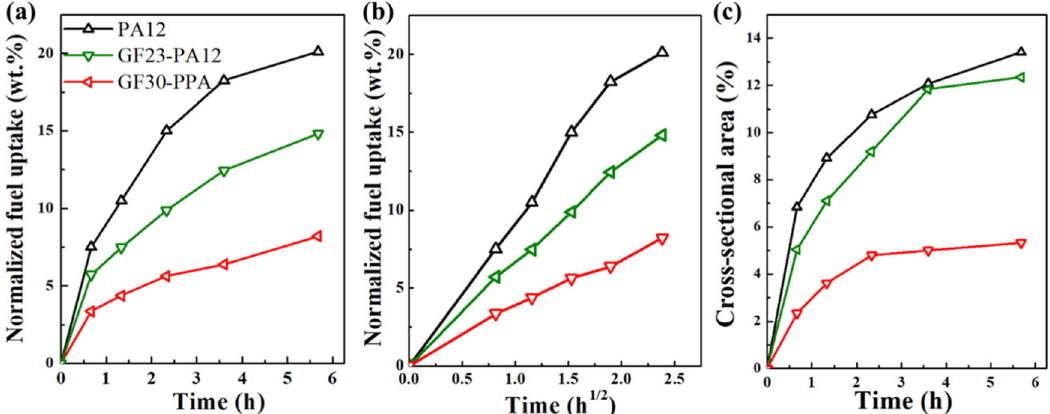
Fig. 1 Fuel sorption and swelling of the samples when exposed to E25. Normalized fuel uptake ( a , b ) and changes in cross-sectional area ( c ) of PA12, GF23-PA12 and GF30-PPA samples at different exposure times in E25 at 120 °C in the glass vials.